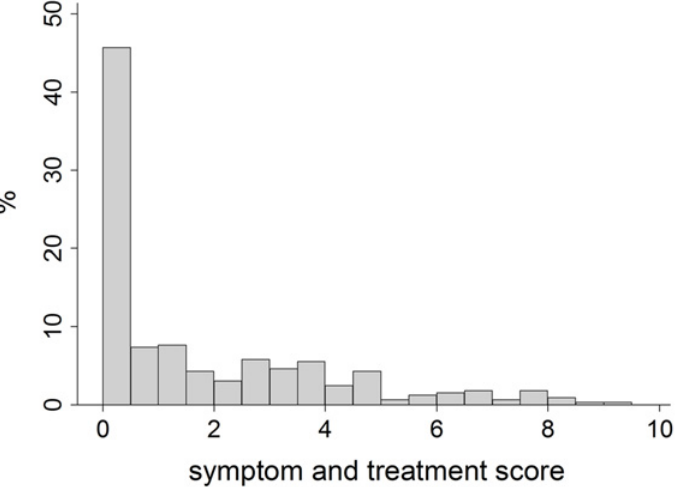
Fig 2. Distribution of the symptom and severity score among the 326 cases of asthma included in the analysis.